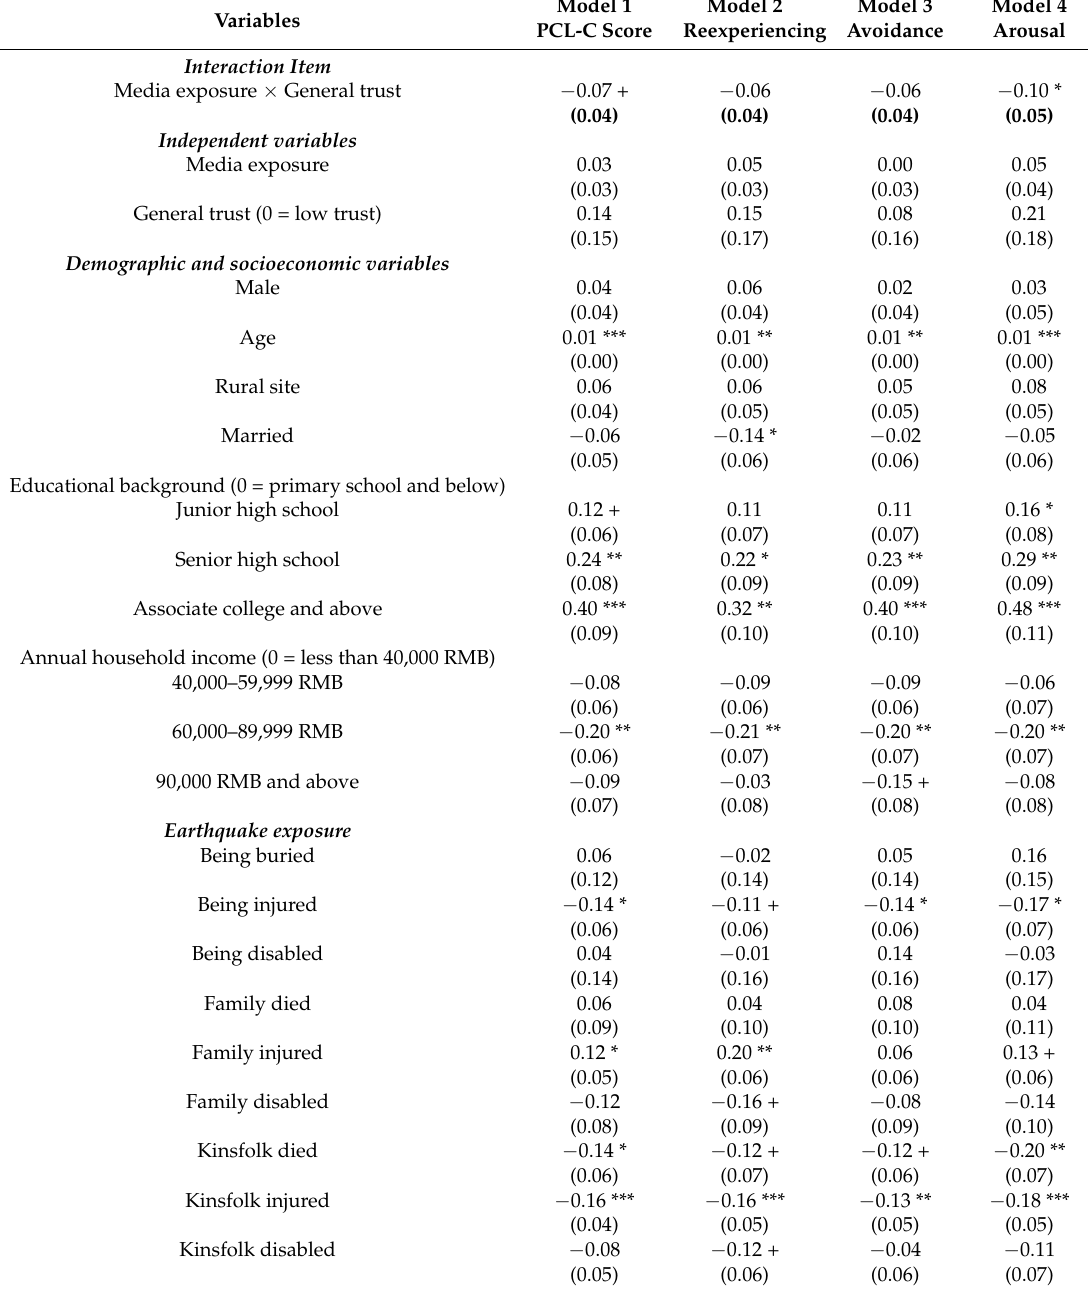
Table 3. Interaction effects of media exposure and general trust on PTSD